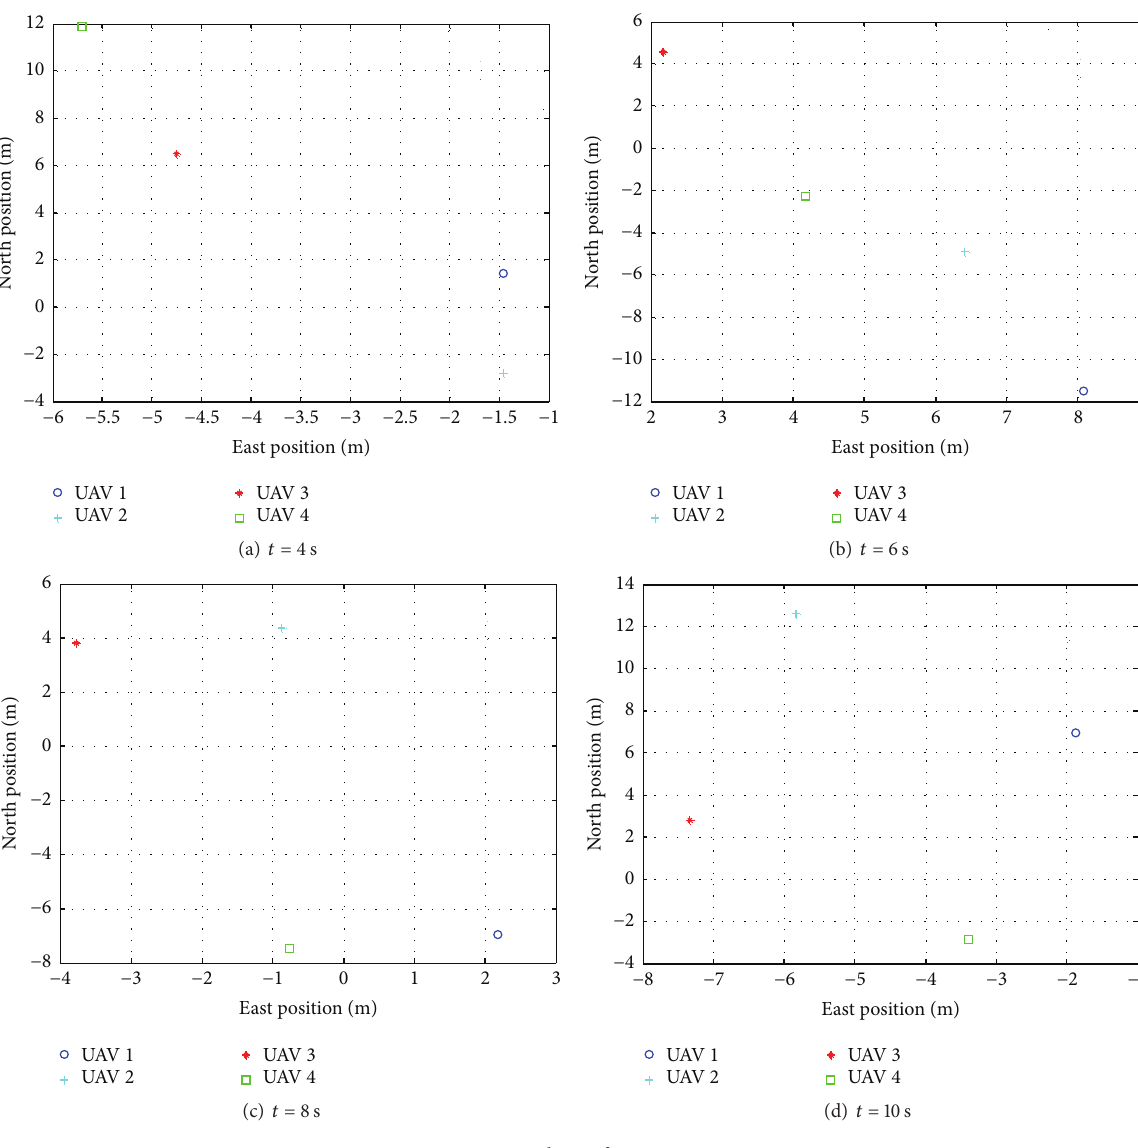
Figure 4: Snapshots of UAV